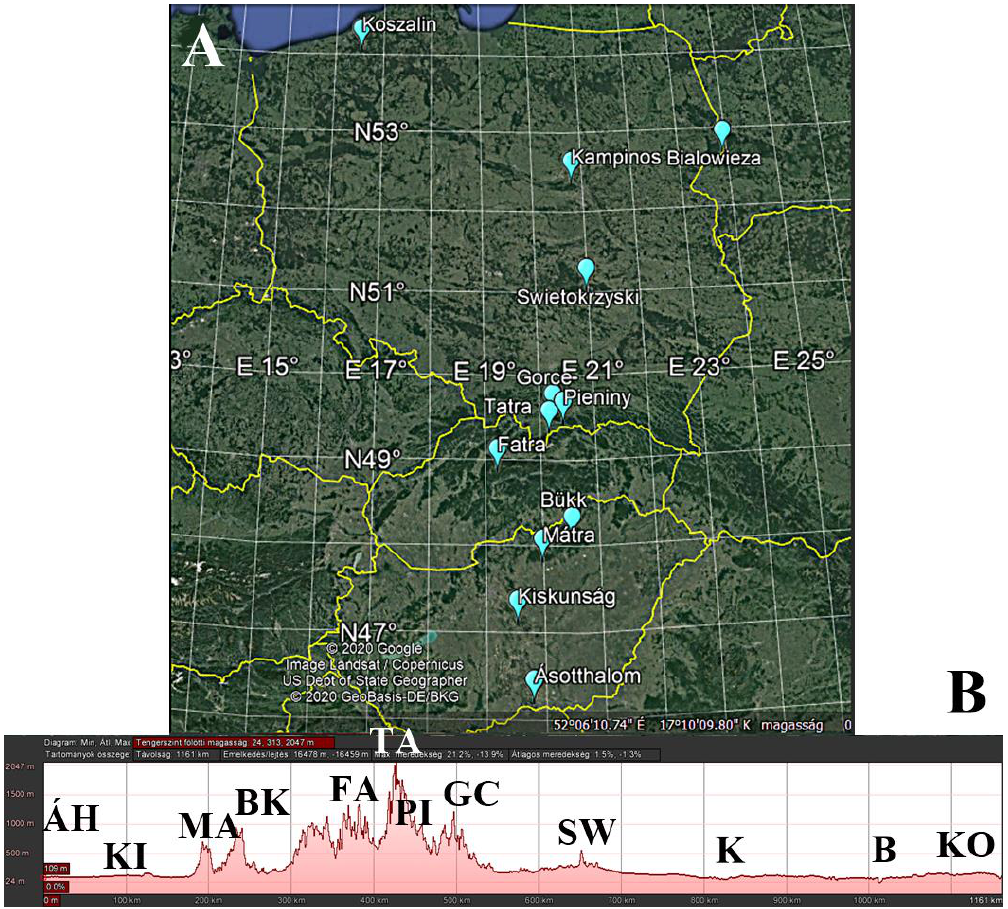
Figure 1. Study regions along the latitudinal ( A ) and altitudinal ( B ) gradient in Central Europe (Hungary, Slovakia, and Poland). Abbreviations: Hungarian lowland: Á H = Á sotthalom, KI = Kiskunság; Southern Carpathian foothill: MA = Mátra; higher Carpathians (mountain range): BK = Bükk, FA = Fatra, TA = Tatra, PI = Pieniny; Northern Carpathian foothill: GC = Gorce; Polish lowland: SW = Świętokrzyska, K = Kampinos, B = Białowieza, KO = Koszalin.